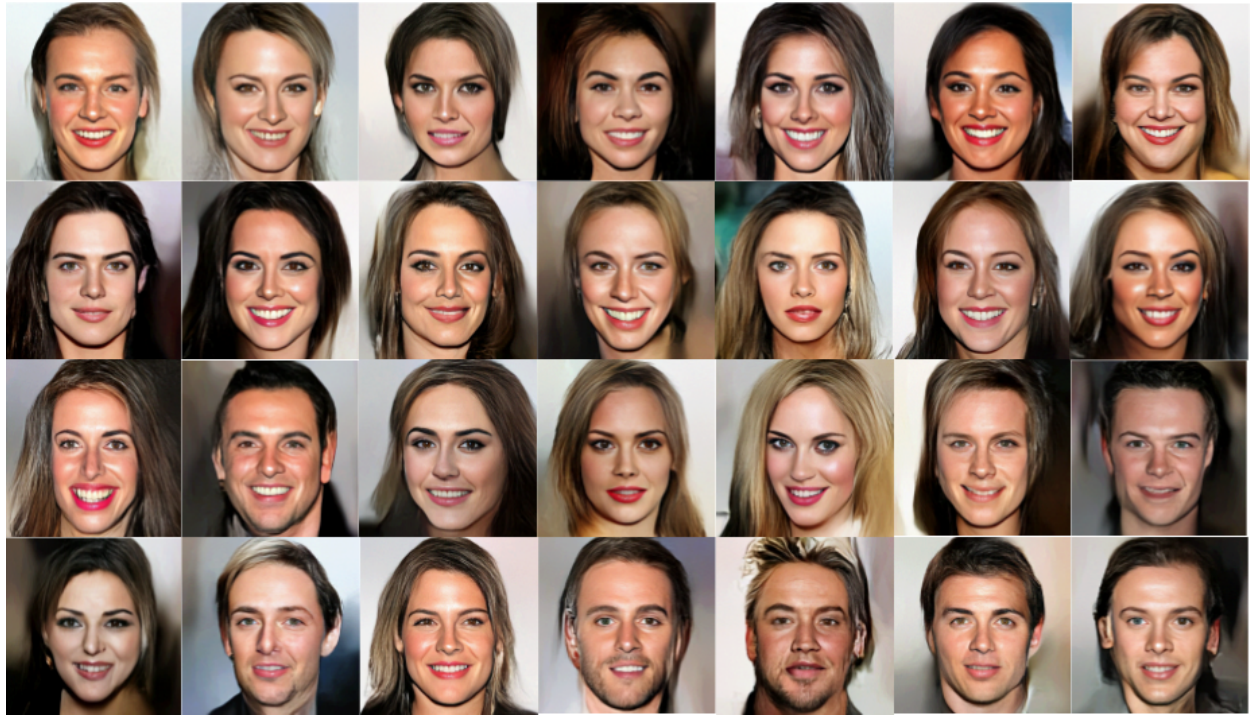
Figure 5. Synthetic celebrity faces sampled from our model trained on the CelabA-HQ